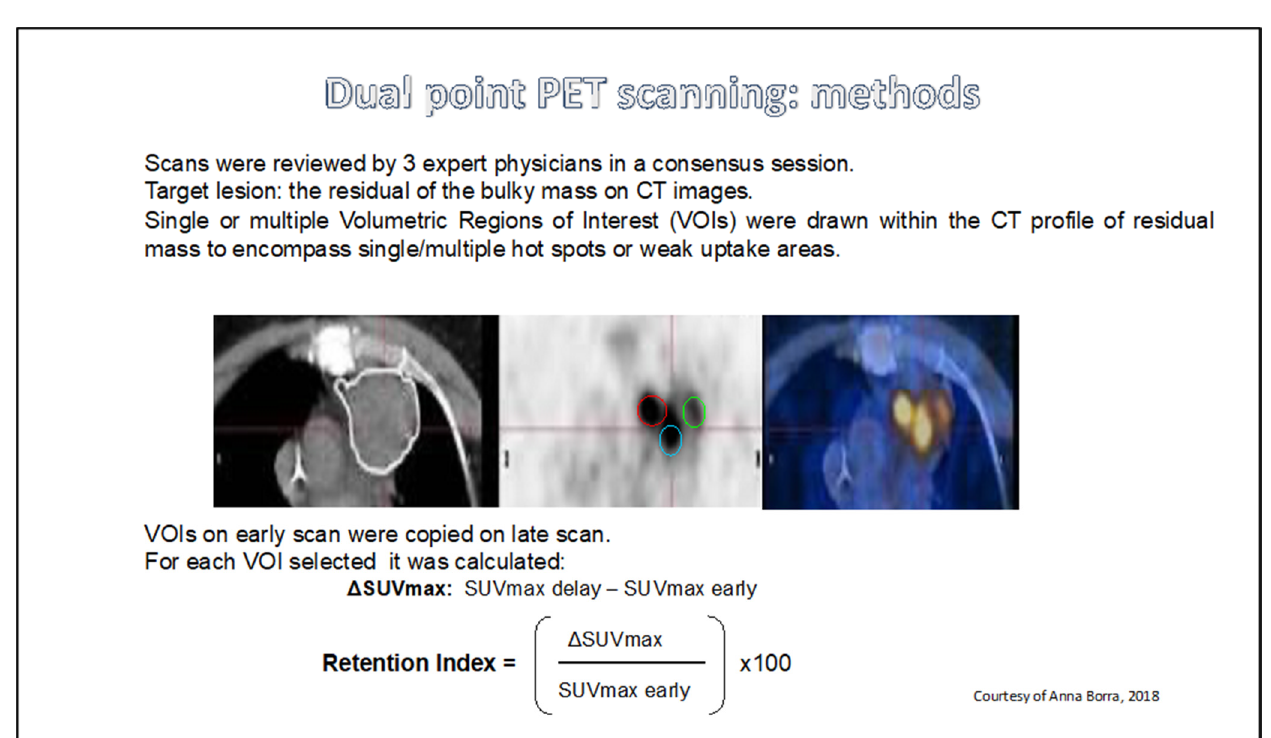
Figure 3. Dual-point PET scanning: methodology. Adapted with permission from Borra et al. [63] by doctor Borra’s permission. Copyright 2018 e-Century Publishing Corporation.